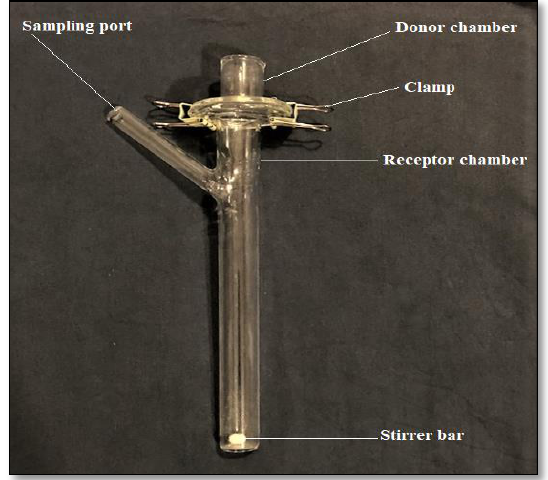
Figure (2) Modified diffusion cell used in the